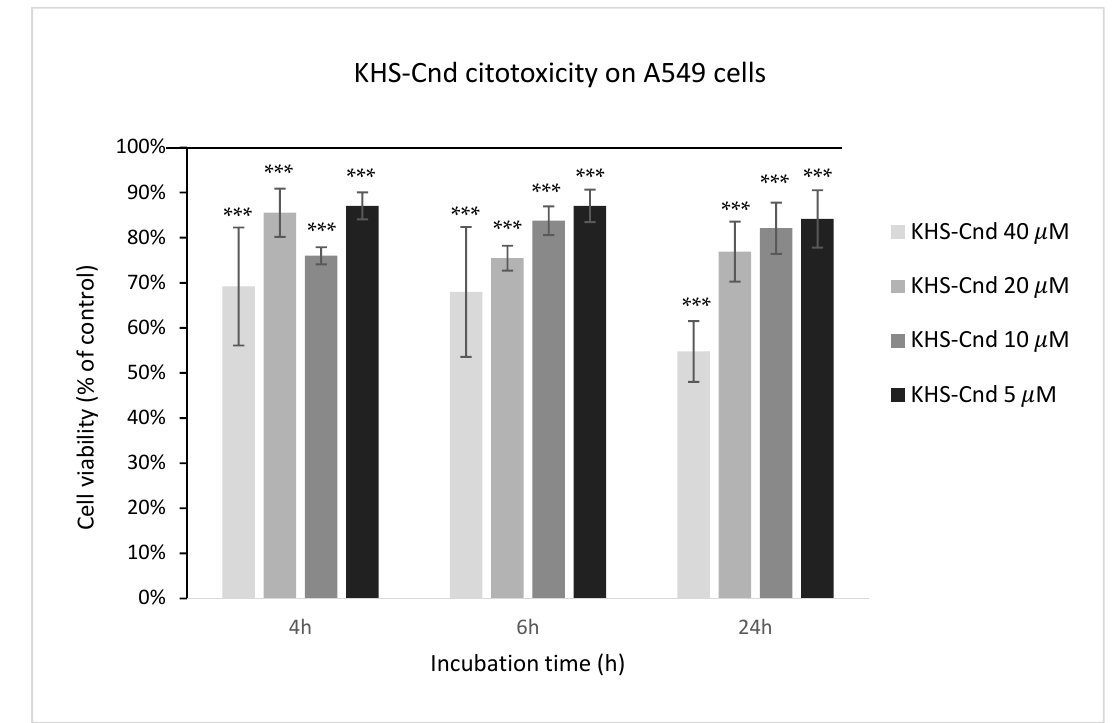
Figure 9. Effect of KHS-Cnd on the A549 immortalized cell line. Dose–response plot of cells after 4, 6, and 24 h of incubation with increasing concentrations (5–40 µM) of peptide. Cell viability was assessed by the 3-(4,5-dimethylthiazol-2-yl)-2,5-diphenyl-2H-tetrazolium bromide (MTT) assay and expressed as described in the Materials and Methods section. Values are given as the means ± SD ( n = 6); *** indicates p < 0.001, with respect to the control cells.